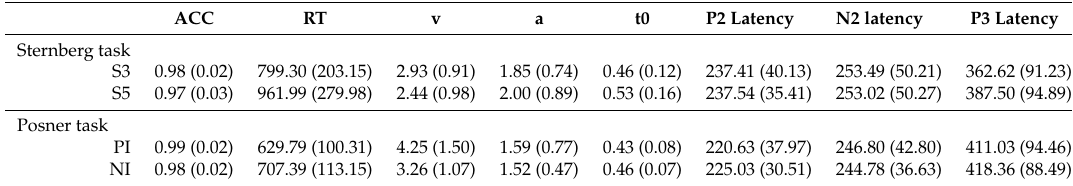
Table 1. Mean (SDs in parentheses) accuracies (ACC), reaction times (RT), diffusion model parameters, and event-related potential (ERP) latencies for each condition of the experimental tasks. ACC RT v a t0 P2 Latency N2 latency P3